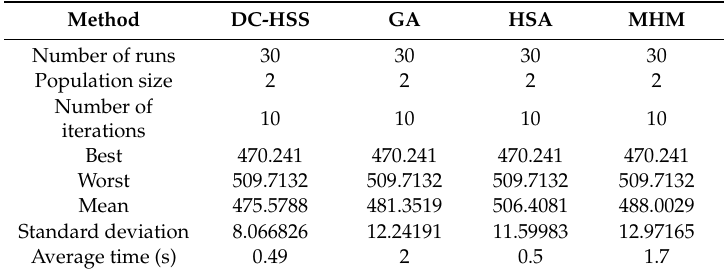
Table 9. Results obtained using the proposed and conventional optimization algorithms: 83-node distribution network.